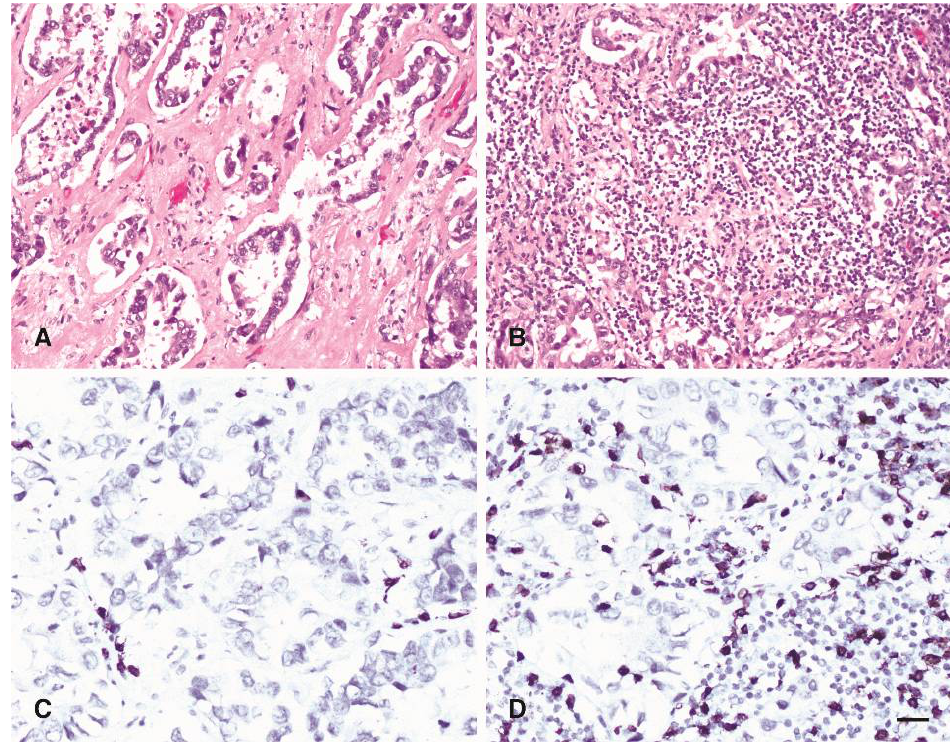
Figure 3. Tumour microenvironment response: ( A , C ) low with few CD8 + cytotoxic lymphocytes, and ( B , D ) high (inflammatory) with numerous CD8+ cytotoxic lymphocytes. Scale bar 25 µ m.